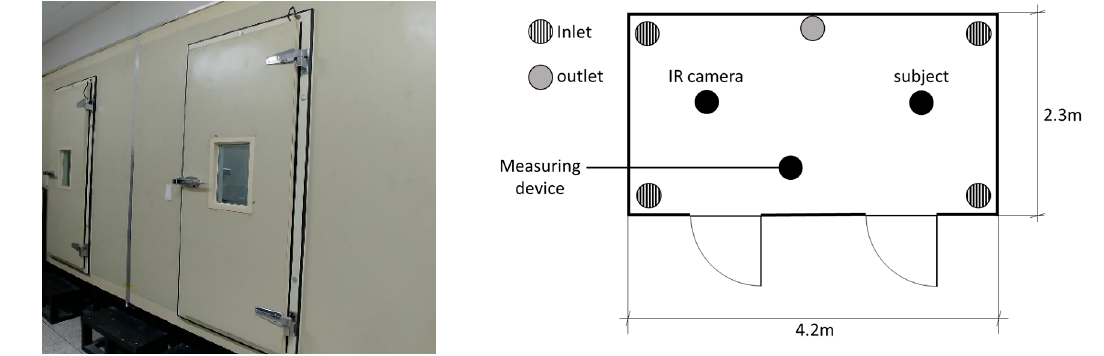
Figure 3. Floor plan of the climate chamber.